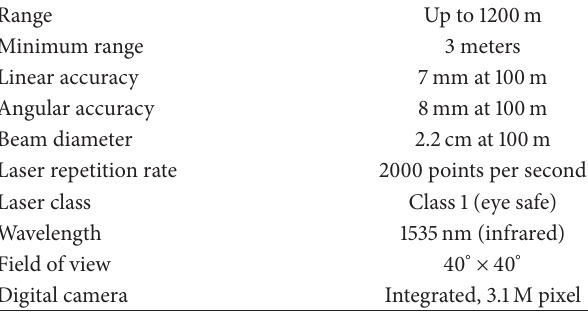
Figure 5: Study area B, Pedra Pintada outcrop, Pedra Pintada Alloformation. The name of this outcrop has its origin due to the different tones of reddish stratification levels. The red color came from different concentrations of iron oxide present in the cement of the sandstones. Table 1: Ilris 3D terrestrial laser scanner technical